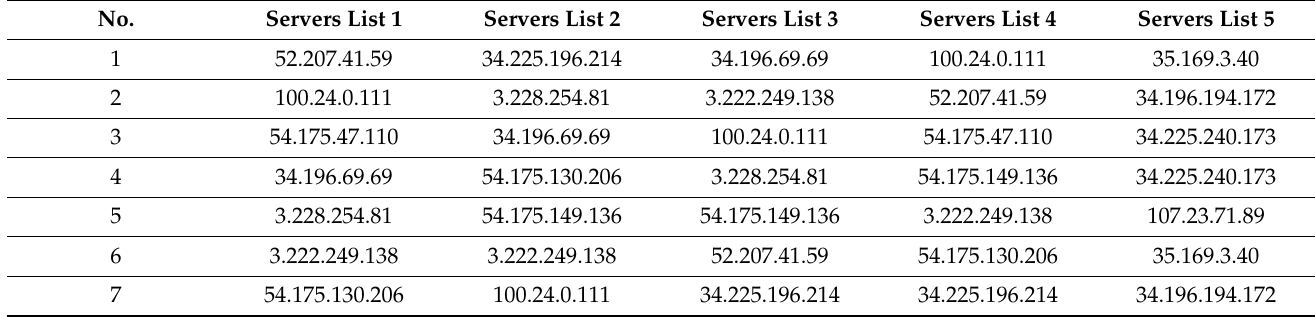
Table 3. Group of chat servers identified during Signal app